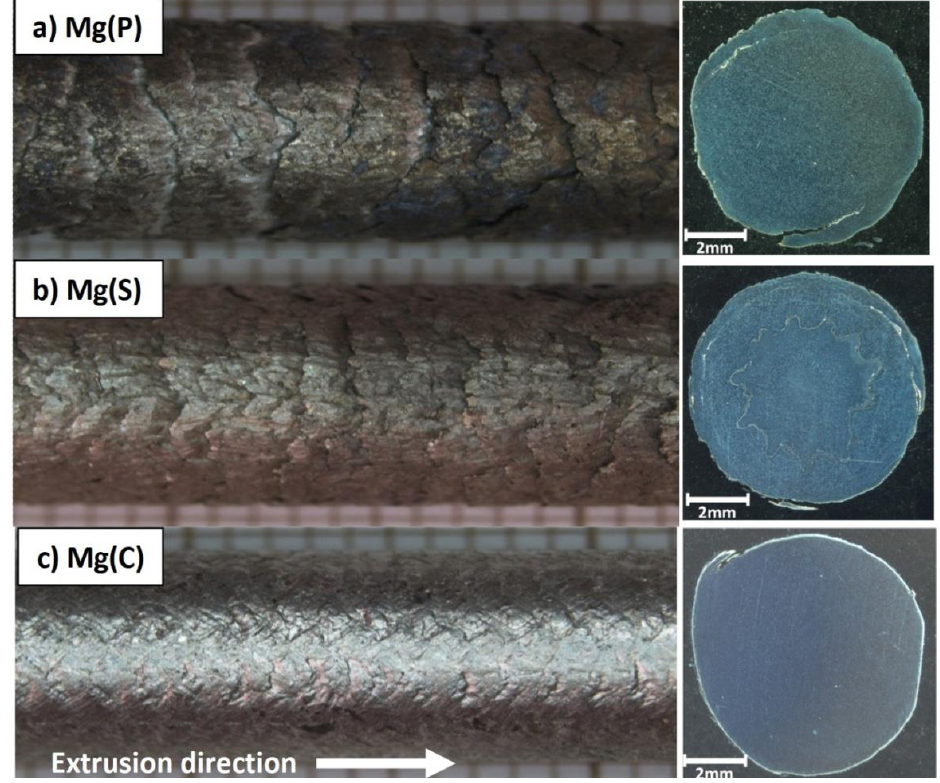
Figure 5. Macrographs of magnesium rod surfaces and cross sections obtained from: ( a ) compacted magnesium powder—Mg(P), ( b ) sintered under pressure magnesium powder—Mg(S), ( c ) cast magnesium—Mg(C). Table 2. Results of open porosity measurements determined by Archimedes